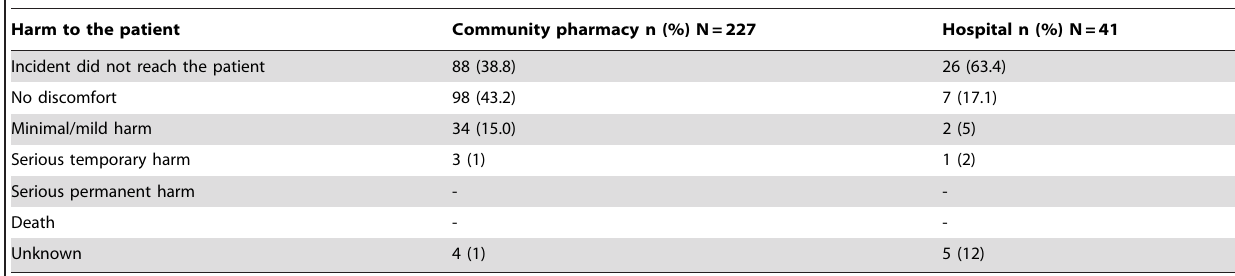
Table 4. Harm to the